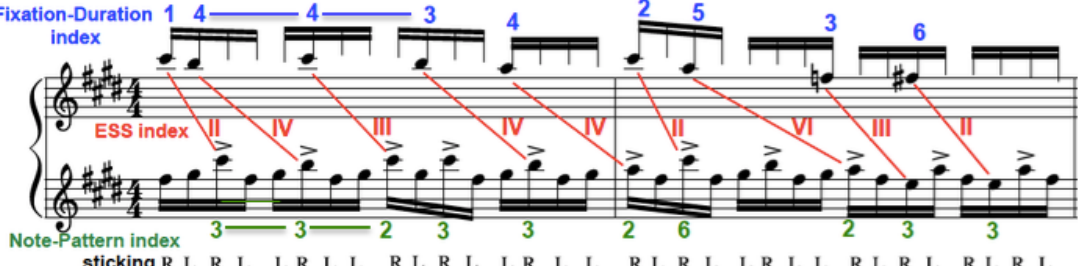
Figure 5. Example of a transcription of the excerpt of ‘Porgy and Bess’ (Player #2, 132 beats-per-minute) including: bottom musical staff, musical excerpt performed by the player; top staff, position of the gaze; in blue, the Duration-Fixation index; in red, the Eye- Stroke Span (ESS) index; in green, the Note-Pattern index; in black, the Sticking (R = right hand, L = left hand).